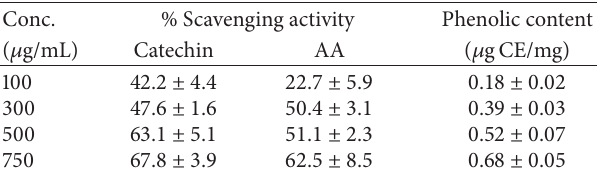
Table 2: The total phenolic contents and scavenging activity of Artocarpus altilis on 2,2-diphenyl-1-picrylhydrazyl radical (DPPH)